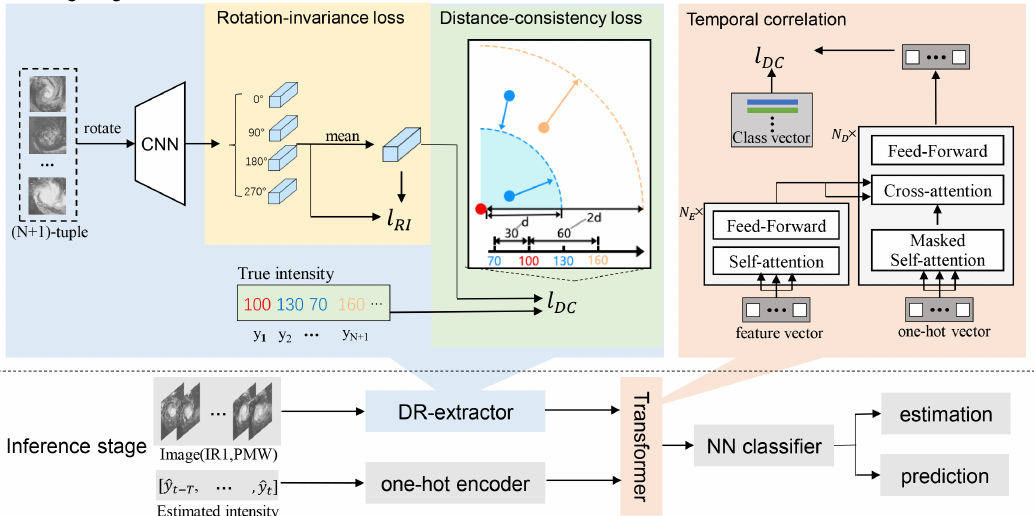
Figure 2. The overall pipeline of the proposed DR-transformer framework. During the inference stage, a series of the image is fed into the DR-extractor to generate the feature vectors sequentially. Meanwhile, we encode the intensity (estimated from classifier) to a one-hot vector. Then, the transformer takes one-hot vectors and feature vectors as input. Finally, the outputs of the transformer pass through a classifier to estimate and predict the